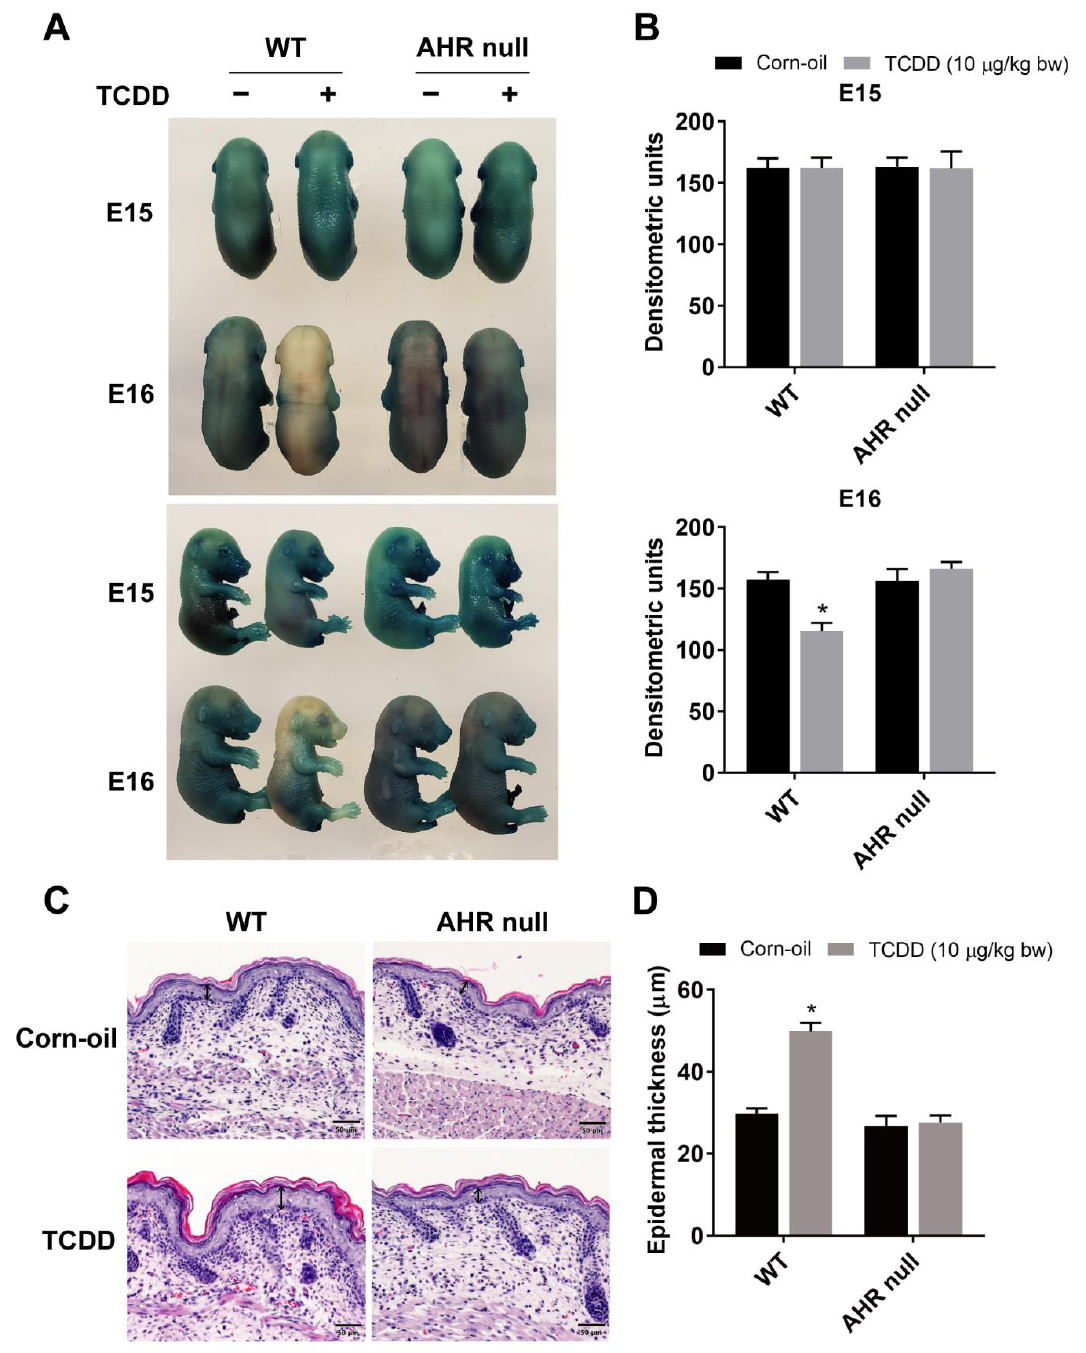
Figure 1. AHR-dependent effects of TCDD on the development of the epidermal permeability barrier. Time-mated mice were treated by gavage with either corn- oil or TCDD (10 μg /kg bw) at E12 or E13 and sacrificed at E15 or E16, respectively ( A , B ). ( A ) Representative photographs of fetuses following the X-gal skin permeability assay. ( B ) Quantitation of X-gal staining by densitometry ( n = 5). ( C ) Representative images of formalin-fixed, paraffin-embedded tissue sections stained with H&E. Time-mated mice were treated by gavage with either corn- oil or TCDD (10 μg /kg bw) at E12 and sacrificed at P1. Scale bar = 50 µm. Double-headed arrows indicate the epidermal thickness. ( D ) Quantitation of epidermal thickness at P1 by microscopy ( n = 5 – 6). Bar graphs display the mean values ± SDs. Data were analyzed by two-way ANOVA fol- lowed by the Tukey test. * p < 0.05, compared to corn-oil control. Abbreviations: AHR, aryl hydrocarbon receptor; TCDD, 2,3,7,8-tetrachlorodibenzo- p -dioxin; bw, body weight; E, embryonic day; X-gal, 5-bromo-4-chloro-3-indolyl- β -D-galacto- pyranoside; H&E, hematoxylin and eosin; P, postnatal day; SD, standard deviation; ANOVA, analysis of variance.